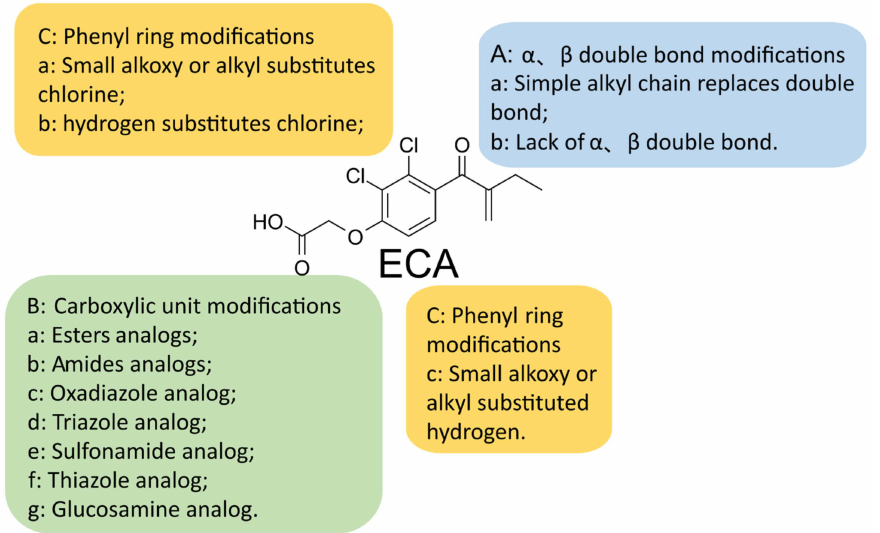
Figure 5. The site of chemical modification of ethacrynic acid